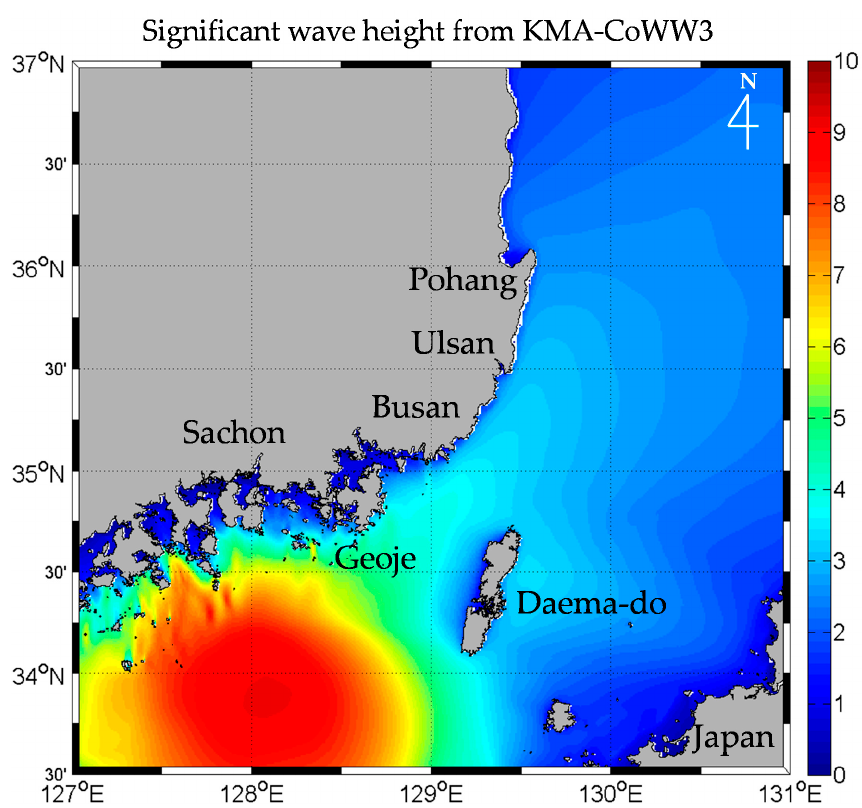
Figure 9. Contour map of simulated significant wave height near the application site.